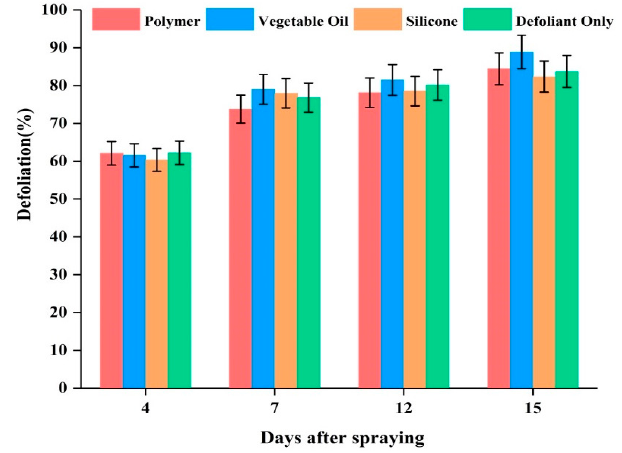
Figure 5. Effect of aviation spray adjuvants on defoliation of cotton sprayed by UAV. Figure 5. E ff ect of aviation spray adjuvants on defoliation of cotton sprayed by UAV.